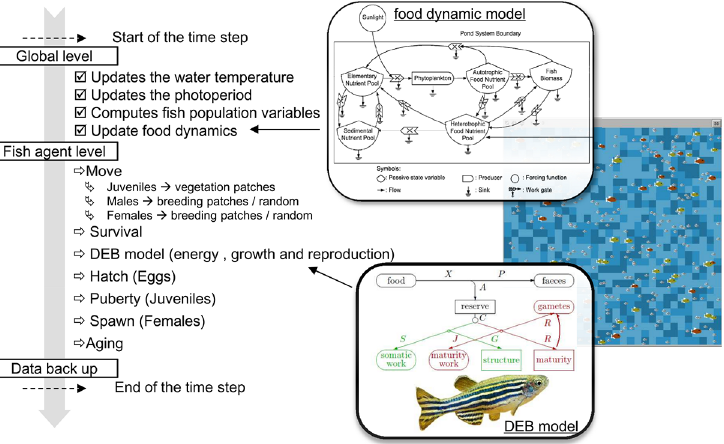
Fig 1. Schema of the schedule of the model of zebrafish population dynamics. Schema of food sub- model was issued from Li and Yakupitiyage [61] and schema of the dynamic energy budget (DEB) model was issued from Kooijman [21]. An arrow before an action denotes that action was realized in random order by fish agents one after another in swift succession.